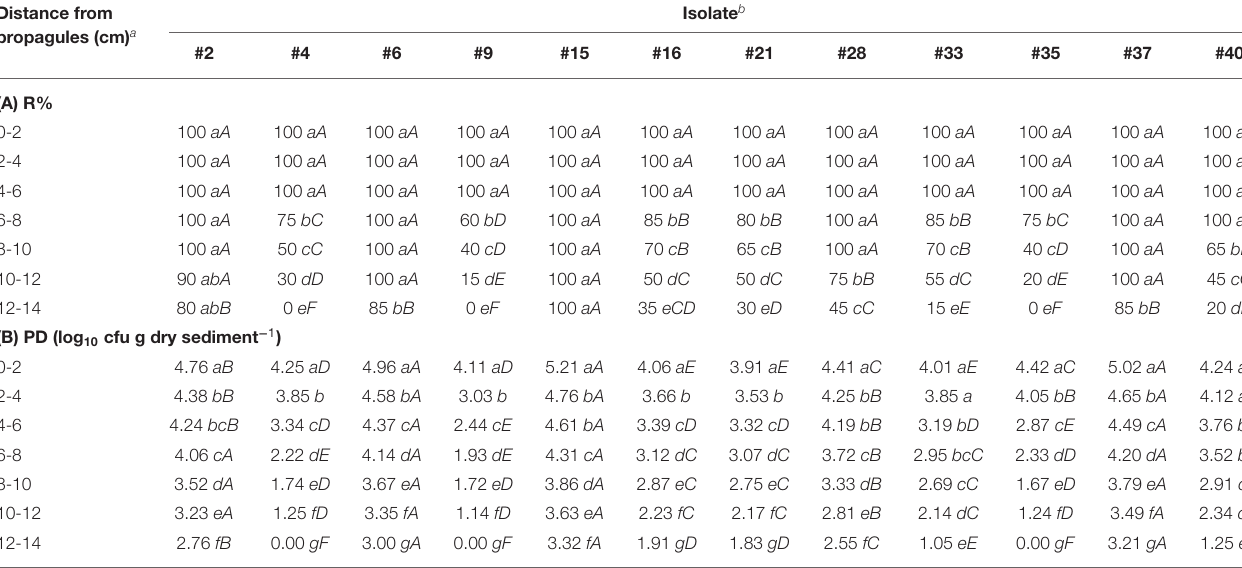
a Mangrovepropaguleswerecoatedwitheachisolateandgrowninnon-sterilefieldmangrovesedimentinplastictubesinpolystyreneboxescontainingsediment,inanevaporative-cooled greenhouse maintained at 28 ◦ C ± 2 ◦ C. b Isolates #2, #15, #6, and #37 represent phosphorus-solubilizing Streptomyces coelicoflavus (Sc) UAE2, auxin-producing Streptomyces polychromogenes (Sp) UAE1, polyamine- (PA-) producing Streptomyces bacillaris (Sb) UAE1, and 1-aminocyclopropane-1-carboxylic deaminase-producing Streptomyces ferrugineus (Sf) UAE1, respectively. For each treatment, means of 16 independent replicates were from two independent experiments. Values with the same lower and upper case letters are not significantly (p > 0.05) different within columns and rows, respectively, according to Fisher’s Protected LSD Test. Percentage data were arc-sine transformed before analysis.